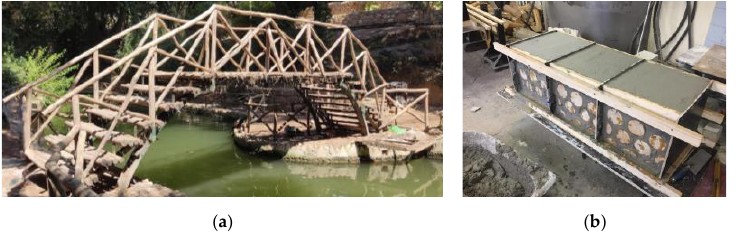
Figure 1. ( a ) Pedestrian bridge with wood logs in Rodini Park, Rhodes; ( b ) cordwood specimens considered in the current study.